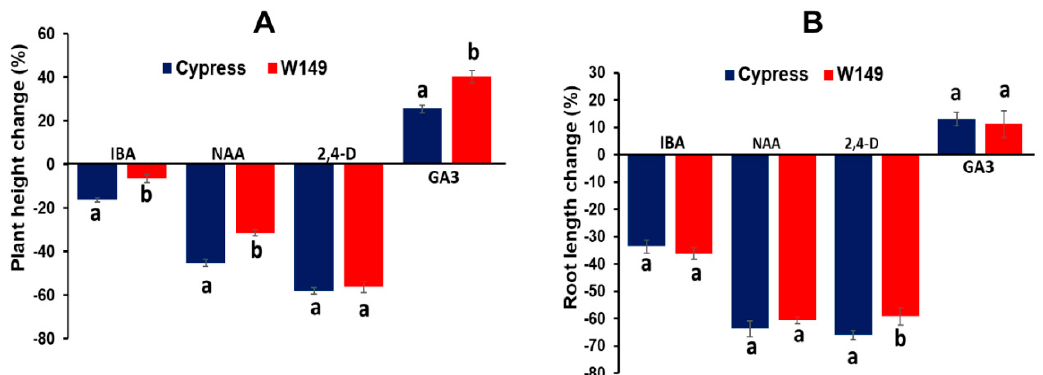
Figure 4. Morphological responses of Cypress and W149 mutant to various plant hormones application. Variations in plant height ( A ) and root length ( B ) after treatment of various phytohormones (0.5 mg / L of nutrient solution) compared to untreated (control) are shown. The hormones are indole-3-butyric acid (IBA), 1-naphthaleneacetic acid (NAA), 2,4-dichlorophenoxyacetic acid (2,4-D), and gibberellic acid (GA3). Means with similar letters indicate no di ff erence in one-way ANOVA analysis ( p < 0.05; n = 10).